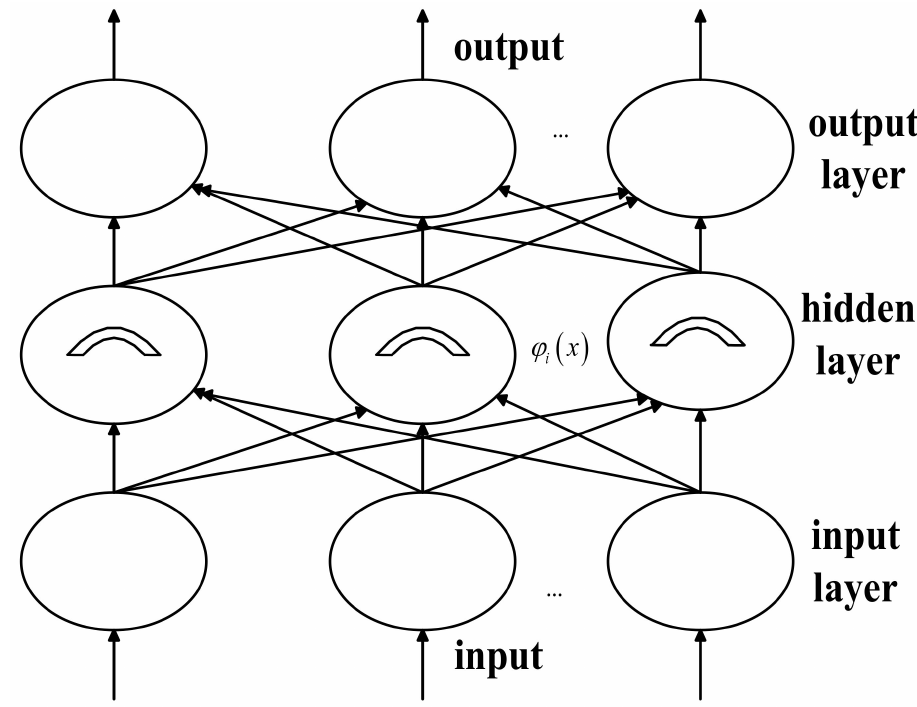
Figure 6. The framework of RBF